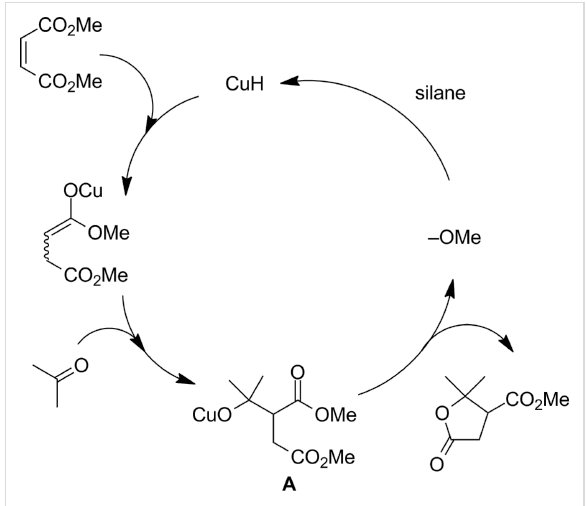
Figure 1: Mechanism of reductive aldol–lactonization reaction of maleate with a carbonyl and silane under copper catalysis.